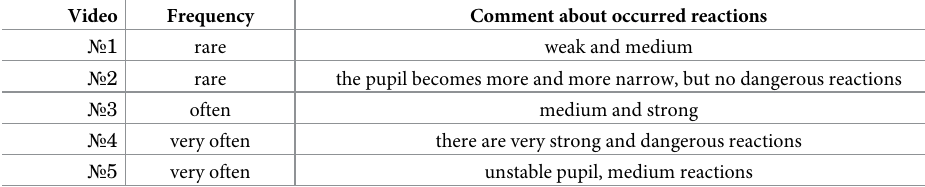
Table 4. The summary of expert opinions for the five new videos. For each video, the frequency and the sizing of pupil reactions are